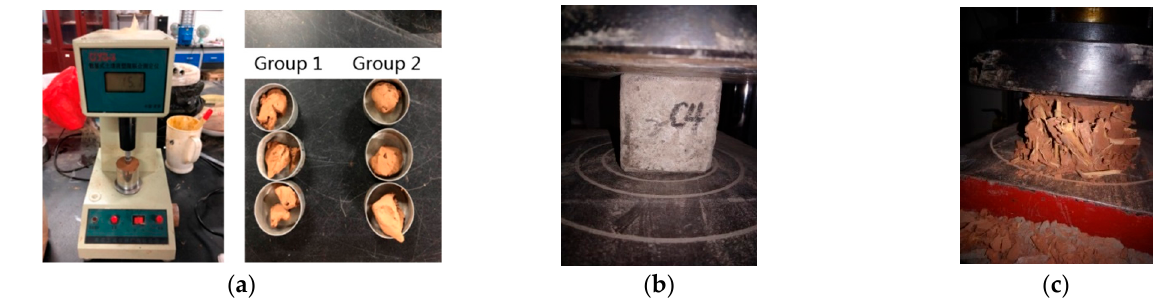
Figure 7. Masonry material tests: ( a ) liquid-plastic limit test of the clay; ( b ) compressive strength test of a block of plastering mortar; and ( c ) compressive strength test of a clay block.